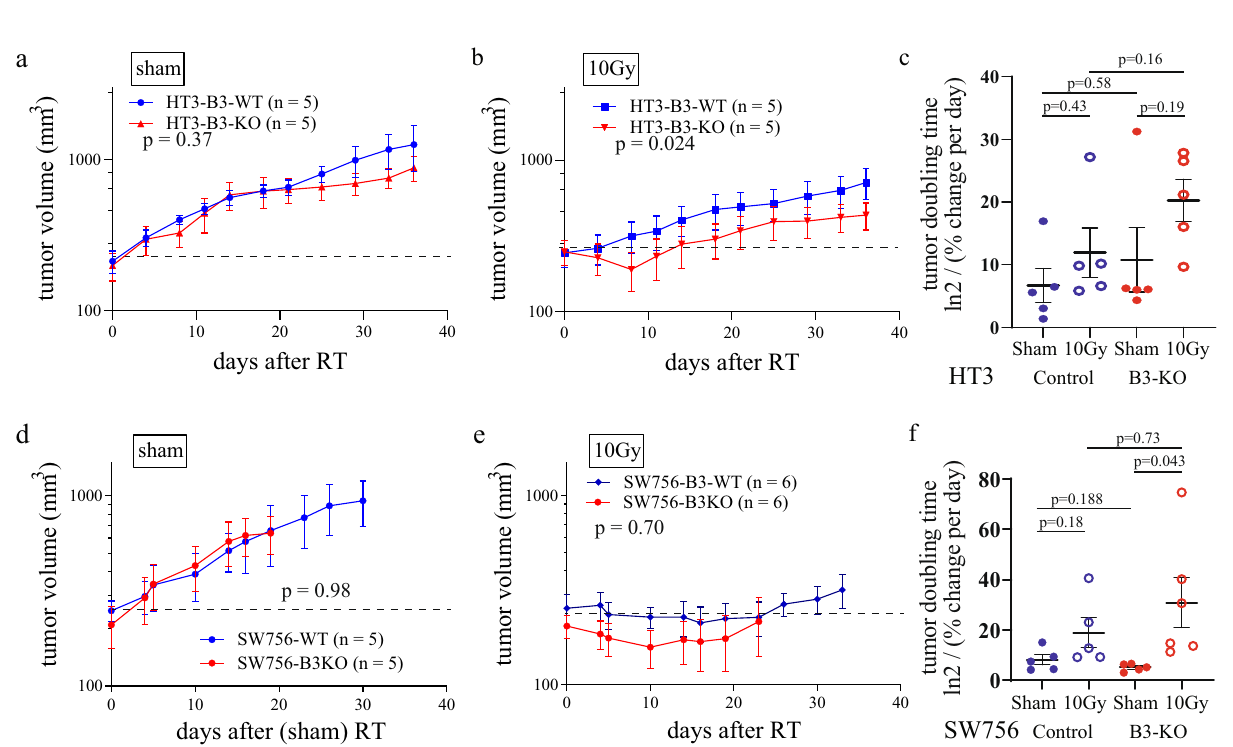
Fig. 2 SERPINB3-KO tumors are more sensitive to radiation in vivo. a , b Mean tumor volume with standard error is plotted over time after RT for HT3- B3-WT and – KO fl ank tumors treated with sham ( a ), or 10 Gy RT ( b ). Number of mice in each group as indicated in the legend, dashed line at mean volume at time of RT. Two-way ANOVA analysis p -value displayed on each graph. c Calculated tumor doubling (ln2/(% volume change per day)) is shown for HT3-B3-WT and – B3-KO cells after sham or 10 Gy. Individual tumors with mean and standard error are shown. P -values from paired t -test comparisons are shown. d , e Mean tumor volume with standard error is plotted over time after RT for SW756-B3-WT and – KO fl ank tumors treated with sham ( d ), or 10 Gy RT ( e ). Number of mice in each group as indicated in the legend, dashed line at mean volume at time of RT. Two-way ANOVA analysis p -value displayed on each graph. f Calculated tumor doubling (ln2/(% volume change per day)) is shown for SW756-B3-WT and – B3-KO cells after sham or 10 Gy. Individual tumors with mean and standard error are shown. P -values for paired t -test comparisons are cisplatin) and HT3 (DMF 0.73 for B3-KO versus 0.96 for cisplatin), and cisplatin did not further sensitize B3-KO cells to radiation (DMF 0.69 vehicle versus 0.67 cisplatin for HT3, and 0.73 vehicle versus 0.75 cisplatin for SW756). Cisplatin did reduce plating ef fi ciency of HT3 but not SW756 cells (Supplemental Fig. 1c, d), indicating a cytotoxic effect in the absence of radiosensitization, which has been previously reported with cisplatin in cervix cancer cell lines 23 .